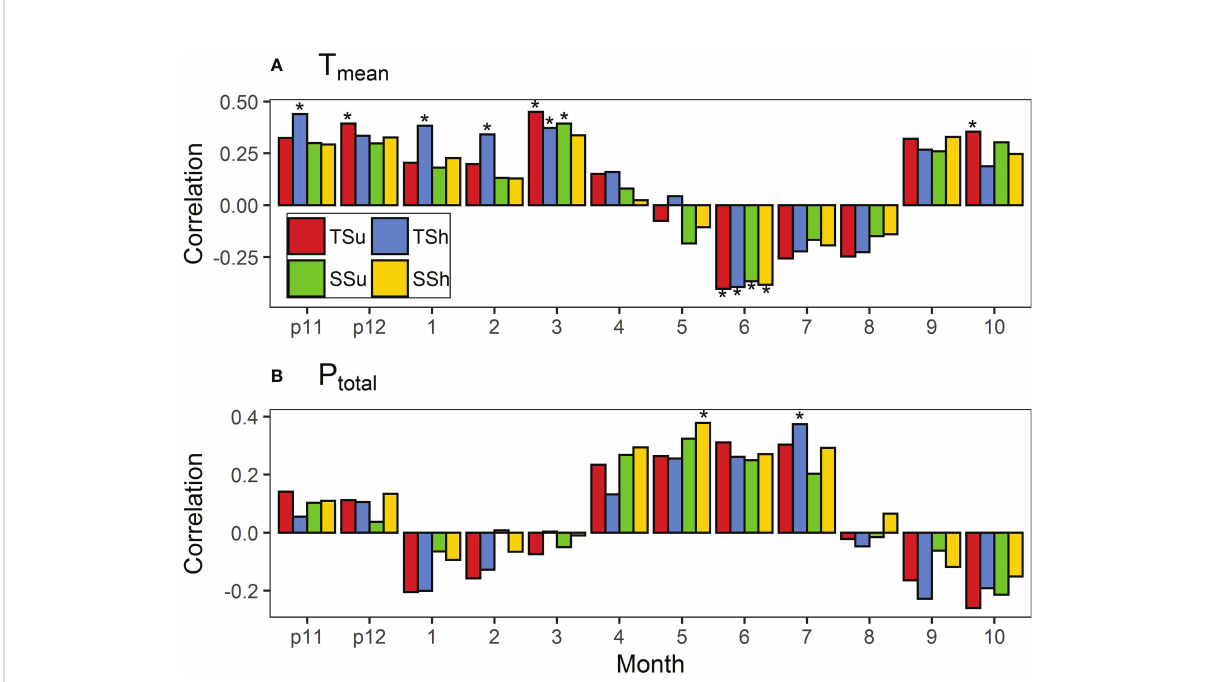
FIGURE 4 Correlations of standard chronologies (STDs) in all plots with (A) monthly mean temperature (T mean ) and (B) total precipitation (P total ). Bars marked with stars indicate that they reached the 0.05 signi fi cance level. “ p11 ” and “ p12 ” represent November and December of the previous year. Bars marked with * indicate that they reached the 0.05 signi fi cance